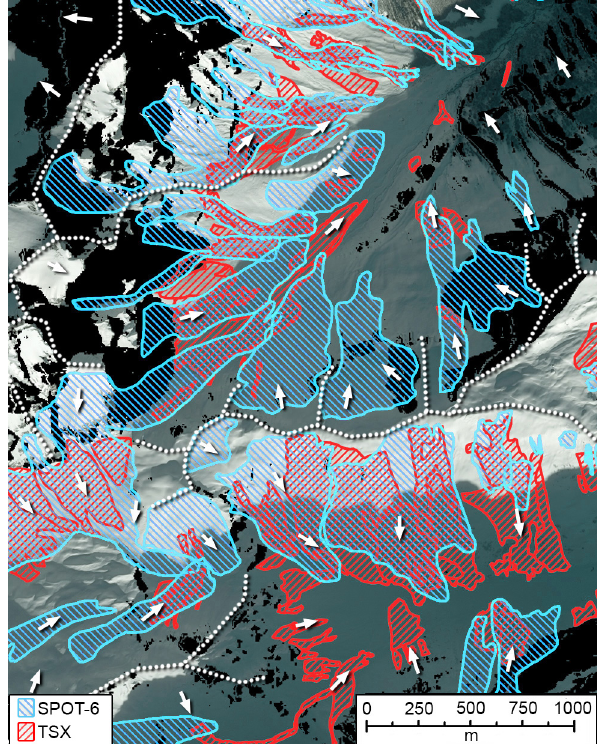
Figure 5. SPOT-6/TSX: manually mapped avalanches (blue) from the SPOT-6 image on 24 January 2018 (background) vs. change detection results from tsx(01-11 / 02-02) (red, all classes) in a sub- set of the entire study area (see Fig. 1). Radar shadow and layover are masked in black. Dots indicate mountain ridges and arrows the downslope direction. The SPOT-6 image was orthorectified with the swissALTI3D © 2019 swisstopo (JD100042), reproduced with the authorization of swisstopo